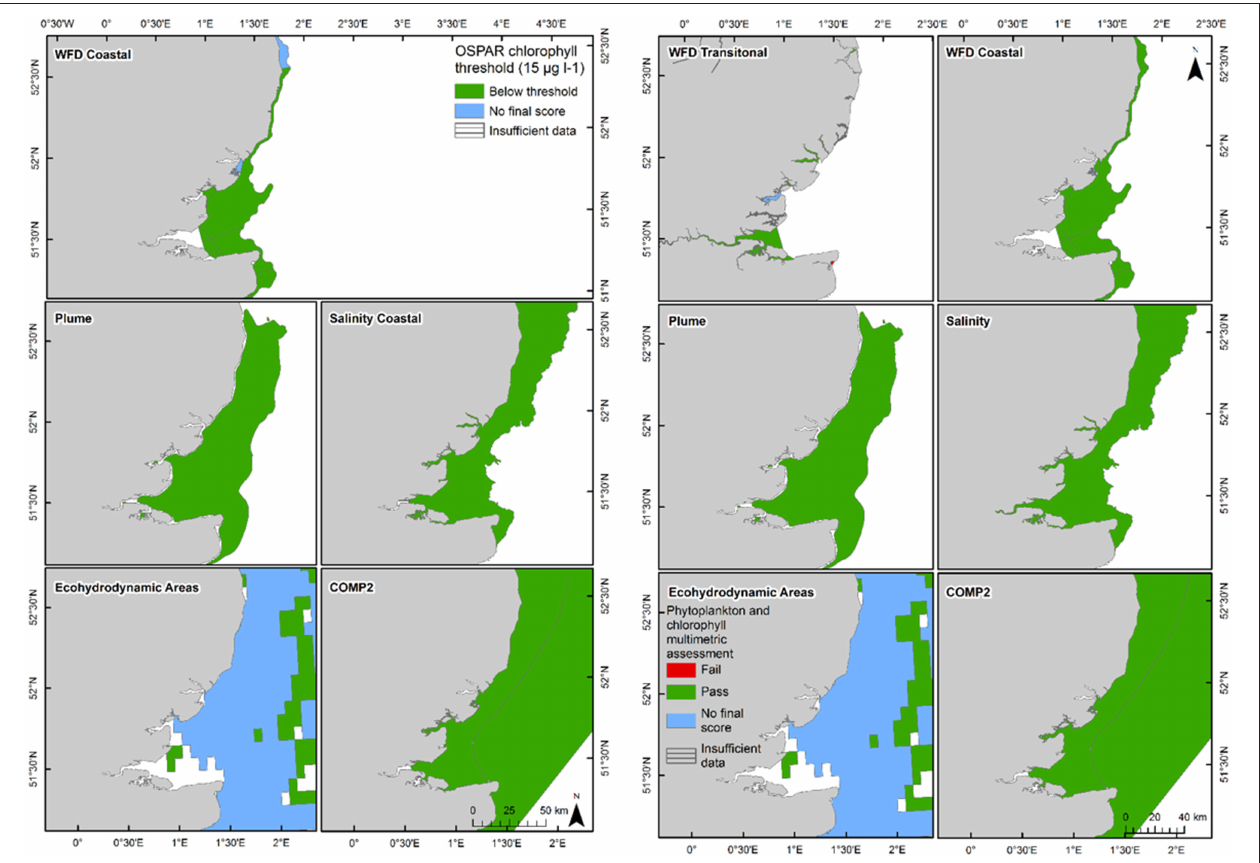
FIGURE 7 | Outcomes for the OSPAR chlorophyll- a assessment (left) and WFD combined chlorophyll-phytoplankton assessment (right) for Thames Estuary.